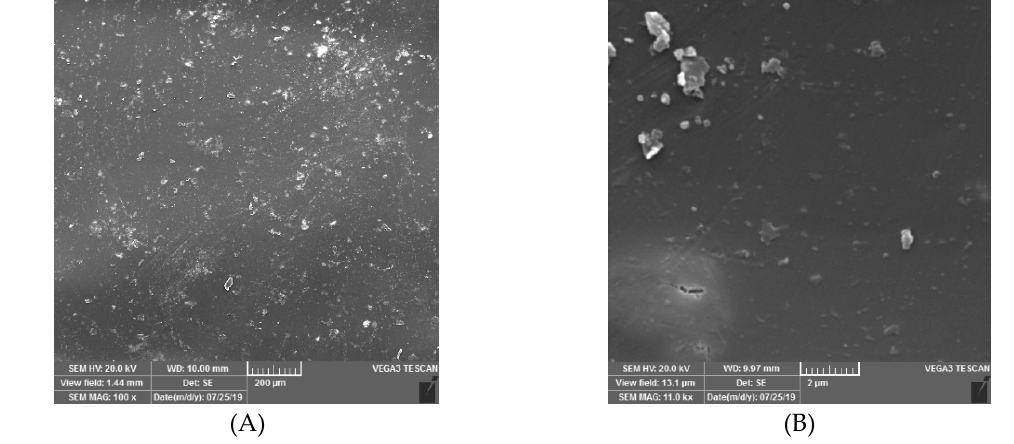
Figure 3. SEM images of poly(1-trimethylsilyl-1-propyne)- Silica nanoparticles (PTMSP-SNPs). ( A ) Surface of membrane ( B ) with high magnification.